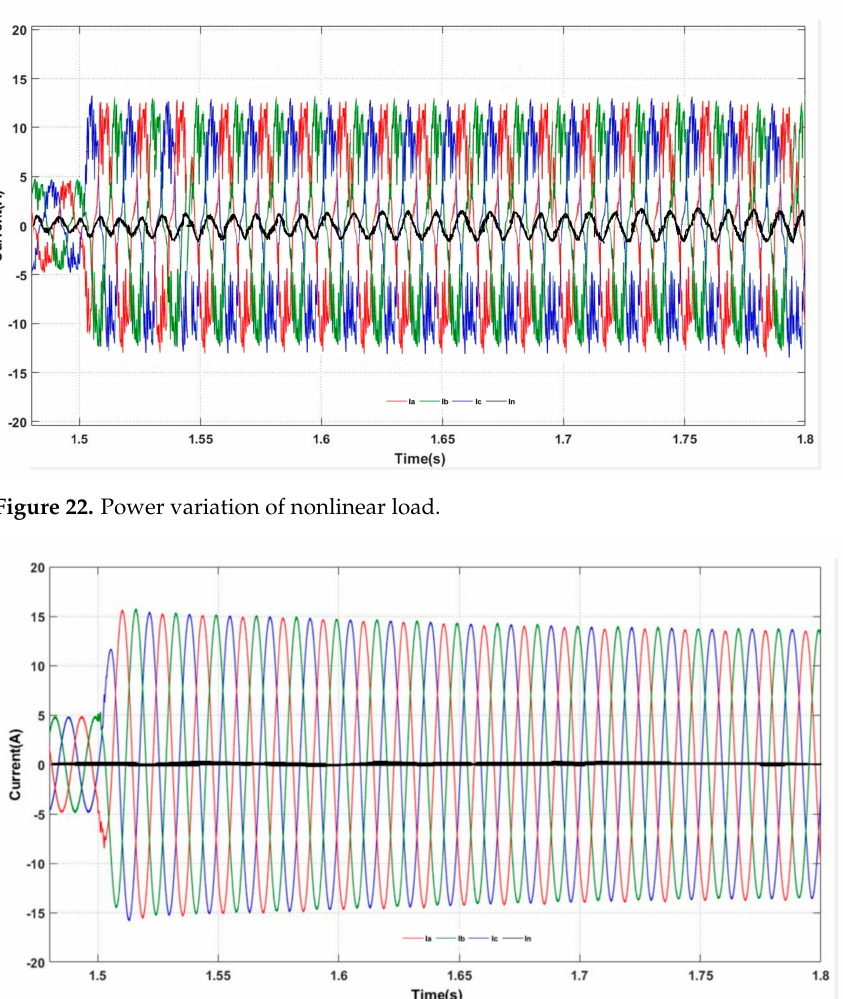
Figure 23. Experimental result of the traditional p-q method for case 4.